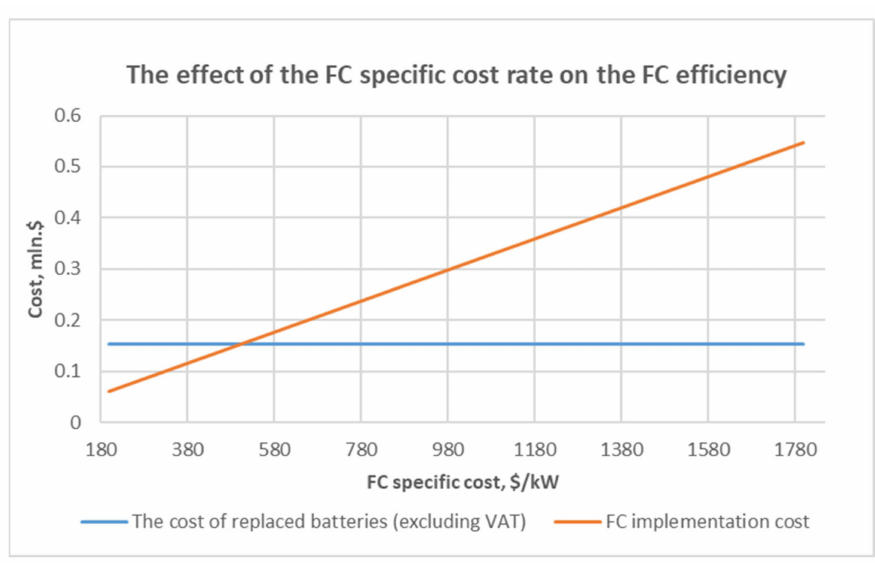
Figure 9. The effect of the FC specific cost rate on the FC efficiency in the case of replacement of TPP batteries by a